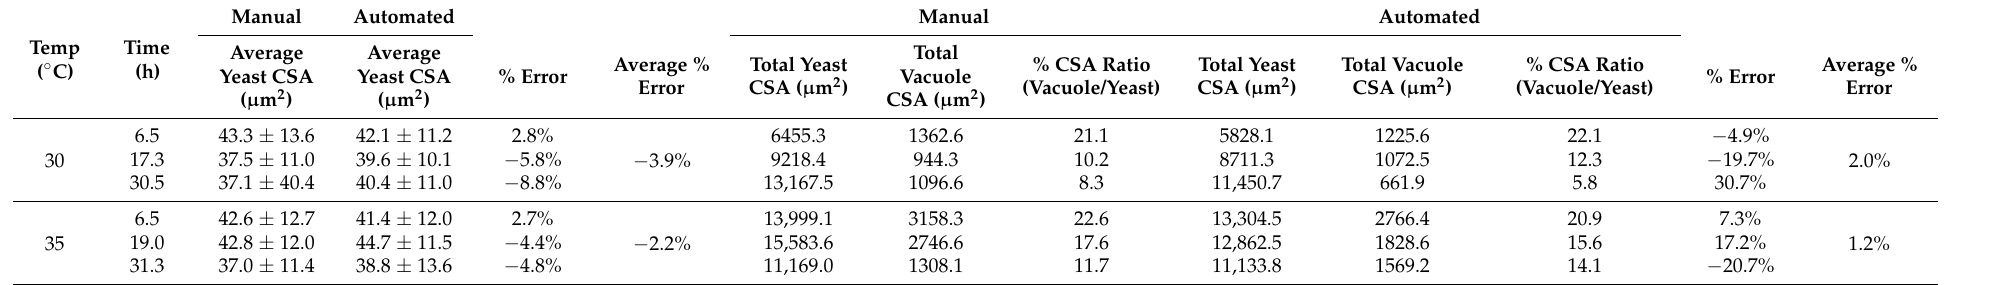
Table 2. Comparison of automated and manual image